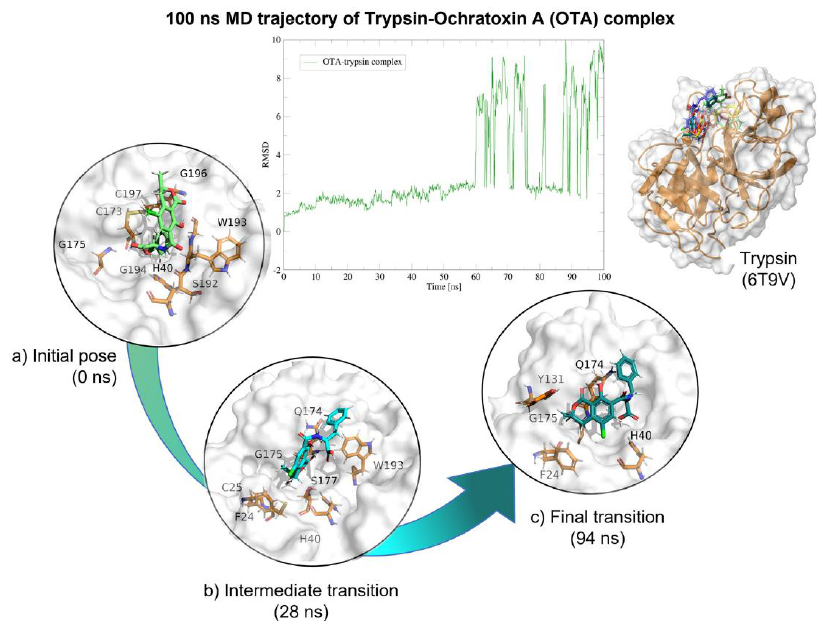
Figure 16. Molecular dynamics of the trypsin–OTA complex. The root mean squared deviation (RMSD) plot shows changes in the complex conformation with respect to the initial state during 100 (ns). The great variation in RMSD found from 58 (ns) is due to trypsin loops near the box limits throughout the 100 (ns). ( a ) Initial pose (0 ns), complex initial state obtained from molecular docking studies. ( b ) Intermediate transition pose visualization where OTA moves within the ligand binding site. ( c ) Final transition where OTA still remains at the trypsin binding site. Green, OTA’s initial pose; Blue, OTA at 28 (ns); Deep green, OTA at 94 (ns). Moreover, in vitro differences between groups were found (ANOVA p = < 0.0001; F = 1.51). Sidak’s multiple comparison s tests showed that bromelain reduced OTA concen- tration by 10.69 (%) at pH 4.6 ( p = < 0.0001; t = 8.88; DF = 12; Figure 17). The final product was identified unequivocally as α -ochratoxin (Figure 18).